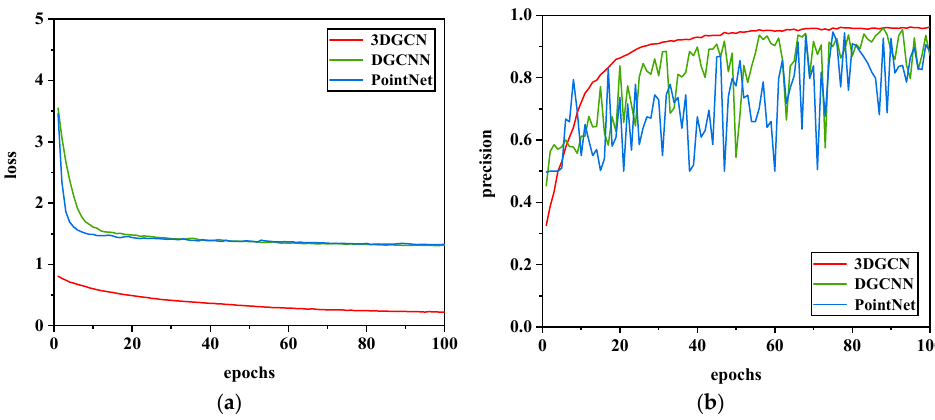
Figure 16. Different point cloud classification network training results. ( a ) Loss curve; ( b ) precision curve.